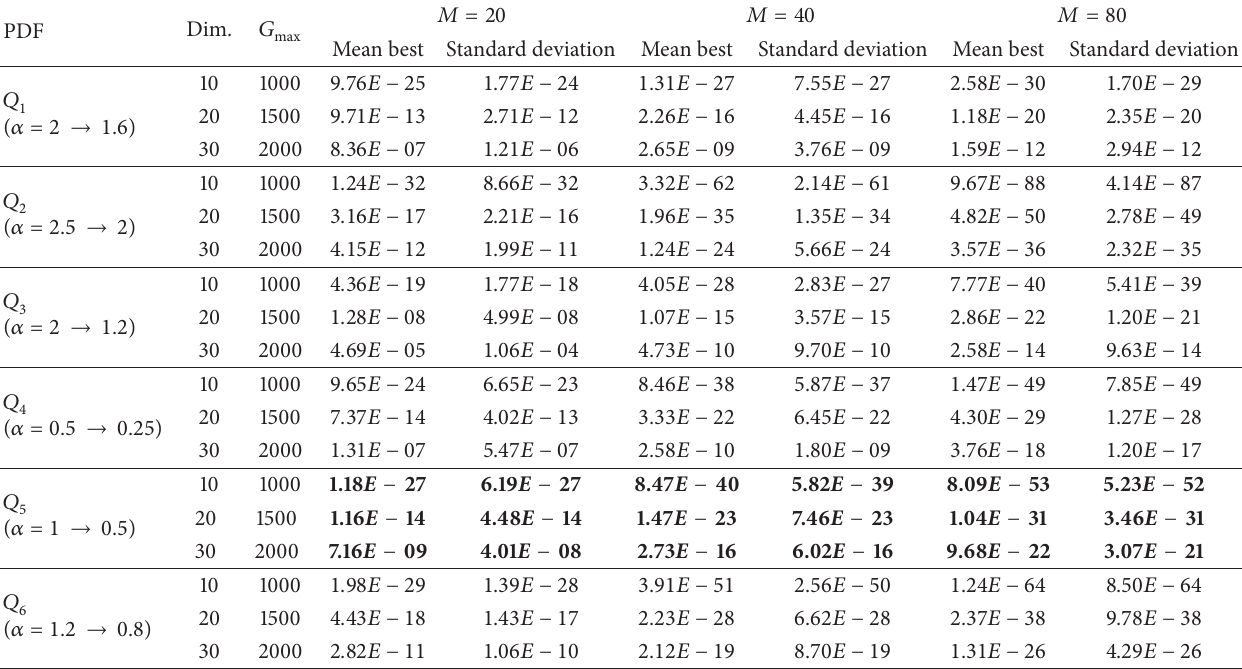
Table 2: Mean best fitness values and standard deviation for the sphere function.